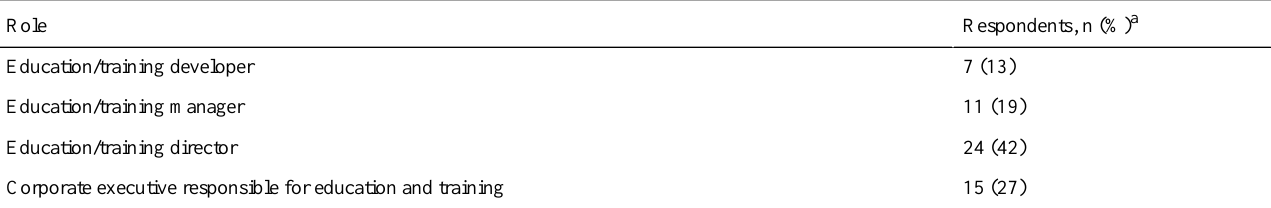
Table 1. Respondents’role.